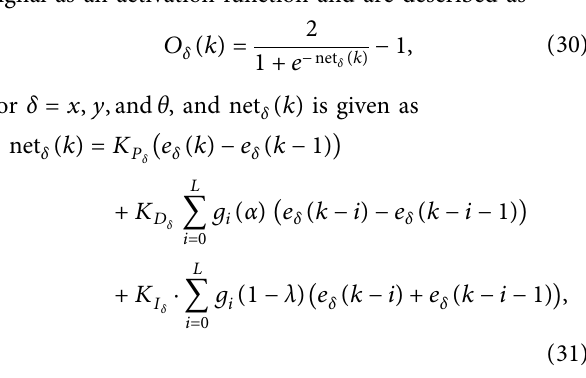
for δ � x, y, and θ . Figure 3 portrays the proposed NNFO- PID controller for the DDMR used in the block diagram of Figure 2. The proposed NN structure is a multilayer perceptron (MLP) which consists of three layers. The first layer is the input layer which sums the error input signals and its past values. The second layer is the hidden layer; it consists of three neurons with nonlinear activation function; they are there to implement the three FOPID controllers needed for the x , y, and θ subsystems of the mobile robot. The